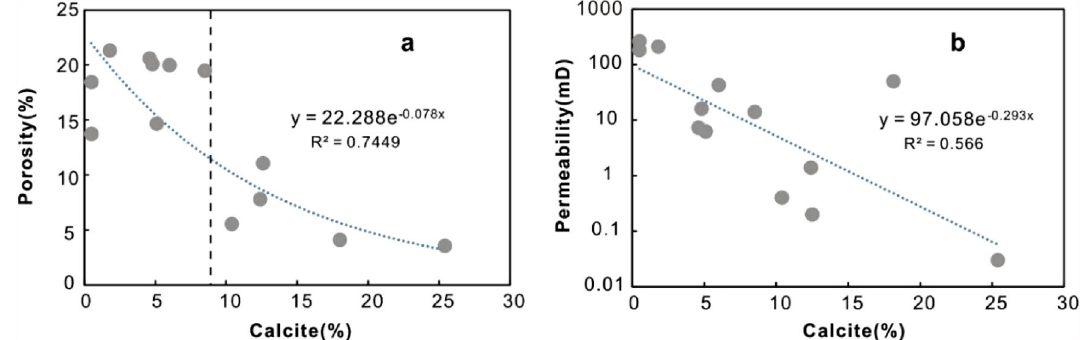
Figure 12. Plot of the calcite versus porosity ( a ) and permeability ( b ) for the Miocene ZJ Formation sandstones of Z21 oil–gas field field in Huizhou Depression. The calcite content was obtained from point-counting on thin sections.